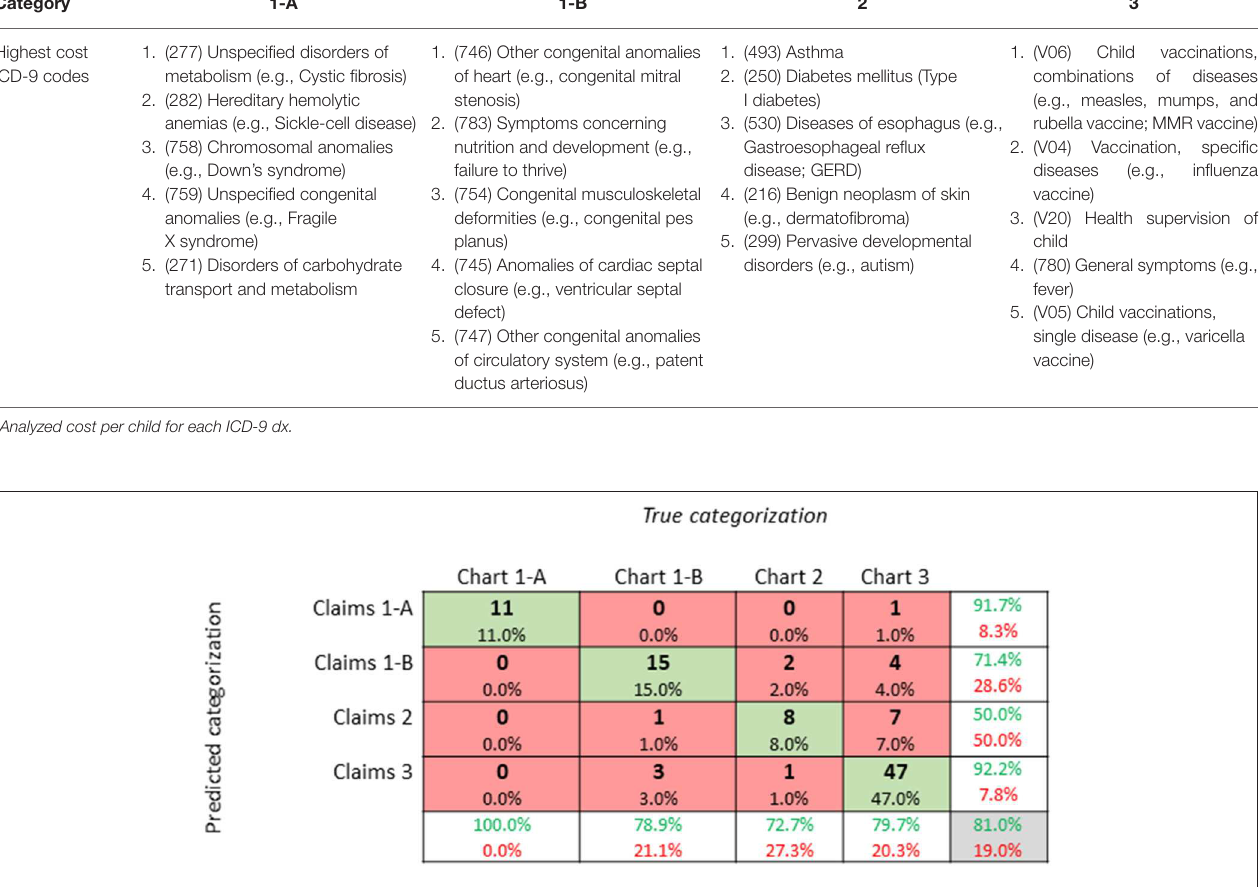
FIGURE 3 | Confusion Matrix of Genetic Categorization Classification Accuracy: A confusion matrix of genetic categorization classifications from a random sampling of 100 patients. Rows correspond to the “predicted” genetic categorization for each patient based on insurance claims data. Columns correspond to the “true” categorization based on a manual review of patient electronic health charts. The diagonal cells shaded in green correspond to observations that are correctly classified, while the non-diagonal cells shaded in red correspond to incorrect observations. The column on the far right shows percentages of claims-based categorizations that are correctly (green text; positive predictive value) and incorrectly (red text; false discovery rate) classified. The row at the bottom shows percentages of chart-based categorizations that are correctly (green text; true positive rate) and incorrectly (red text; false negative rate) classified. The cell in the bottom right shows the overall accuracy (81%) of our categorization